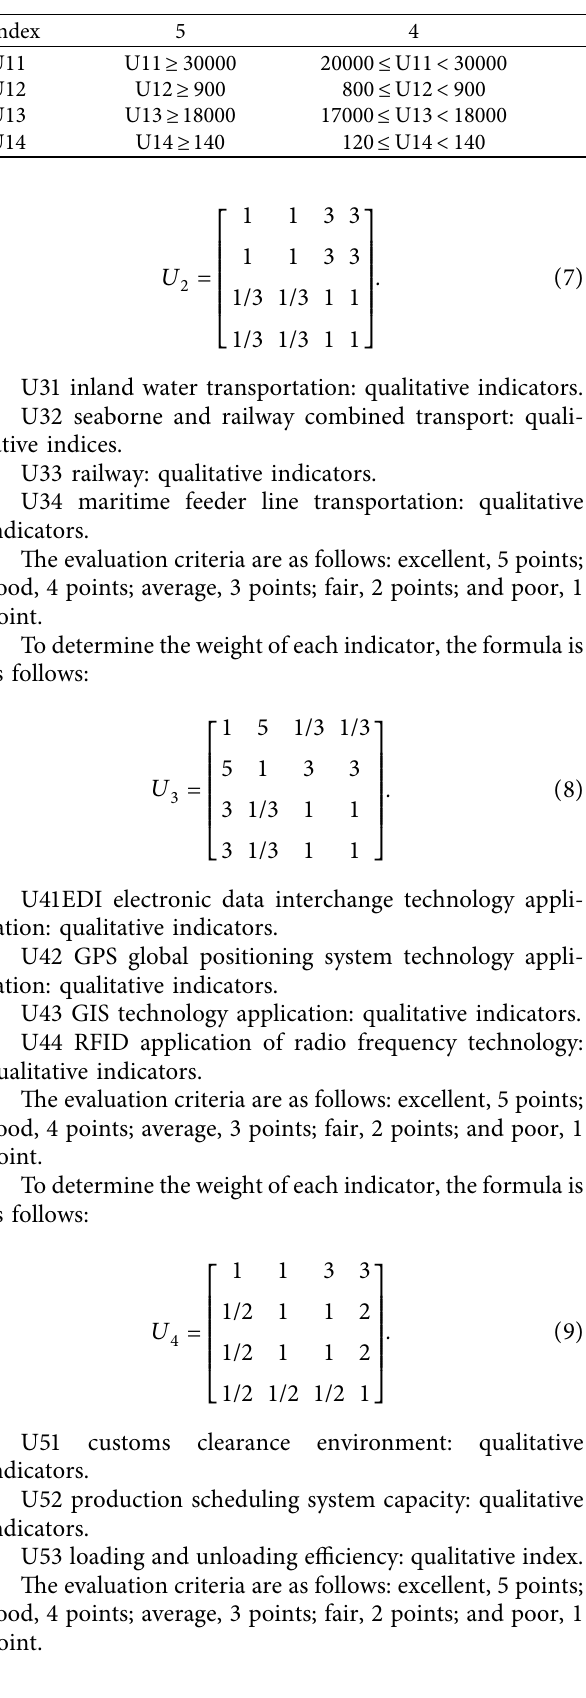
Table 1: Scoring standard